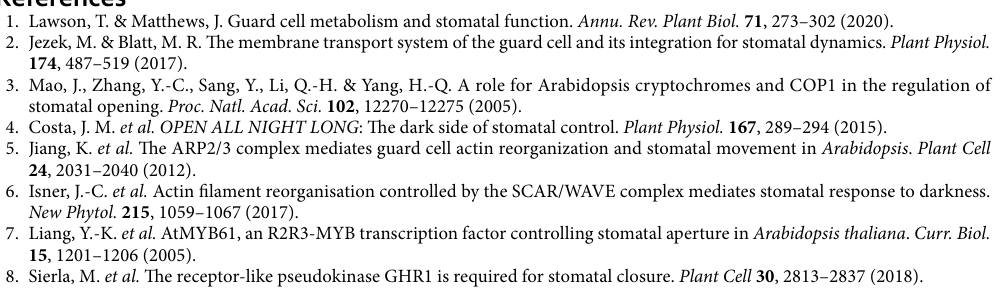
Supplementary Table S1. The collection of the plant material used in this study complied with relevant institu- tional, national, and international guidelines and legislation, and the collection of plant seed was carried out in accordance with national